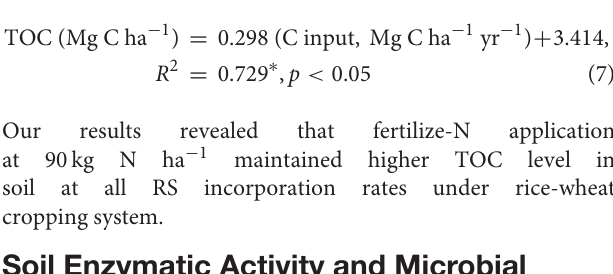
TABLE 7 | Effect of fertilizer-N application and rice straw (RS) incorporation on dehydrogenase activity (DHA), fluorescein diacetate (FDA) and alkaline phosphatise (Alk-P) in surface (0–7.5cm) and sub-surface (7.5–15cm) soil depth under rice-wheat cropping system in north-western India. Treatment